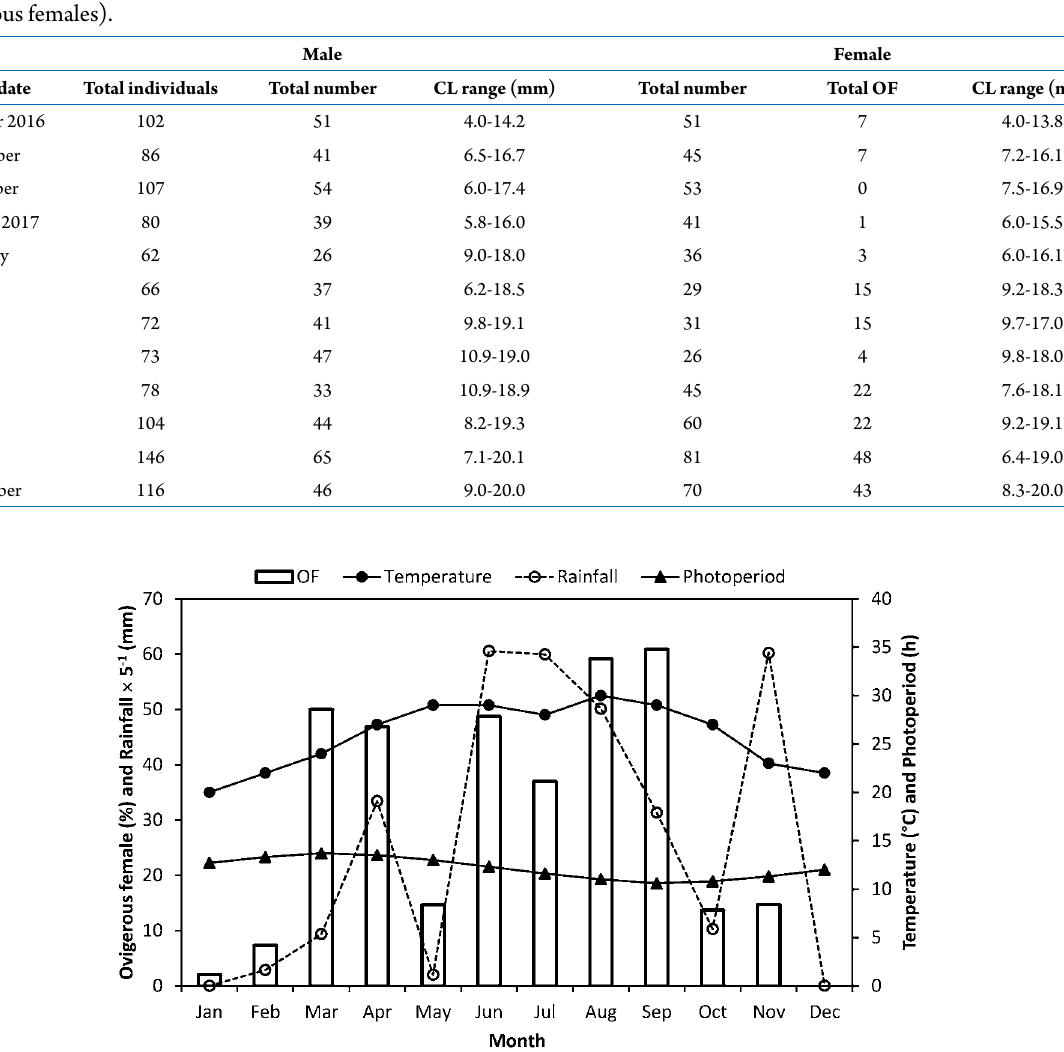
Figure 1. Monthly changes in percentage occurrence of ovigerous females of Macrobrachium lamarrei collected from a wetland, northeastern Bangladesh and average monthly variations of rainfall, air temperature and photoperiod during October 2016